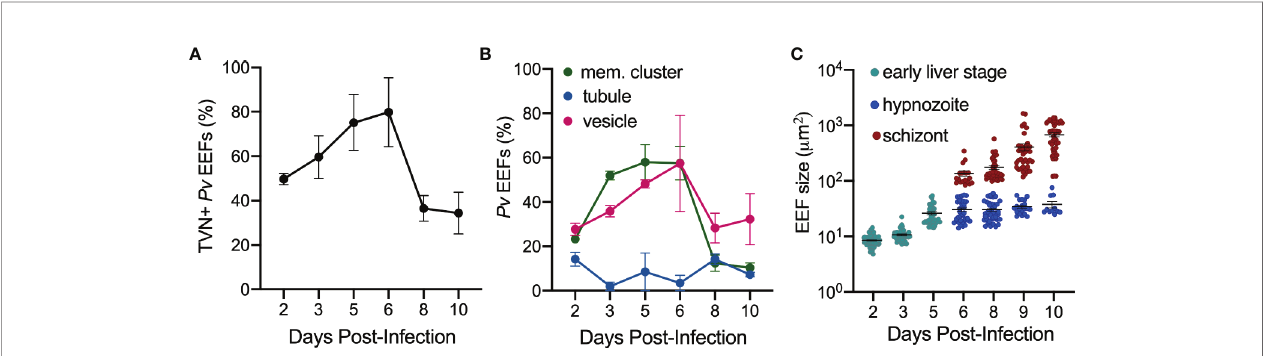
FIGURE 3 | Characterization of P. vivax TVN throughout infection. (A) Percentage of P. vivax TVN+ EEFs (black) throughout infection of PHH (2 – 10 dpi). (B) Percentage of total P. vivax EEFs with indicated TVN characteristic days 2 – 10 post-infection of PHH. TVN+ EEFs are classi fi ed into exhibiting extended membrane clusters (mem. clusters, green), tubules (blue), and TVN-derived vesicles (vesicles, magenta). (C) P. vivax EEF size days 2 – 10 post-infection of PHH. Differentiation is shown between early liver stage (teal), hypnozoites (blue), and schizonts (red). Data reported as mean area ± SEM for each stage (early liver stage, hypnozoite, and schizont) per day. (A, B) Data reported as mean ± SEM (>30 EEFs each day, n=2 biological